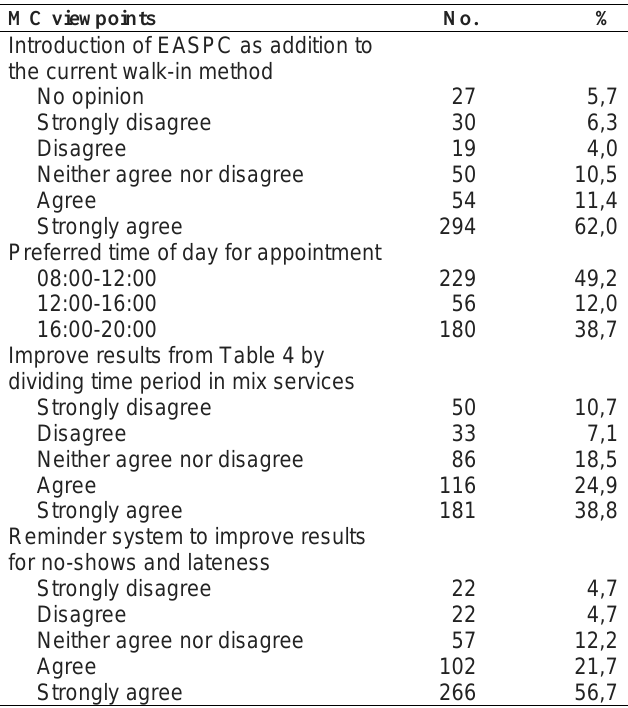
Table 3. MC Viewpoints on introducing EASPC to the